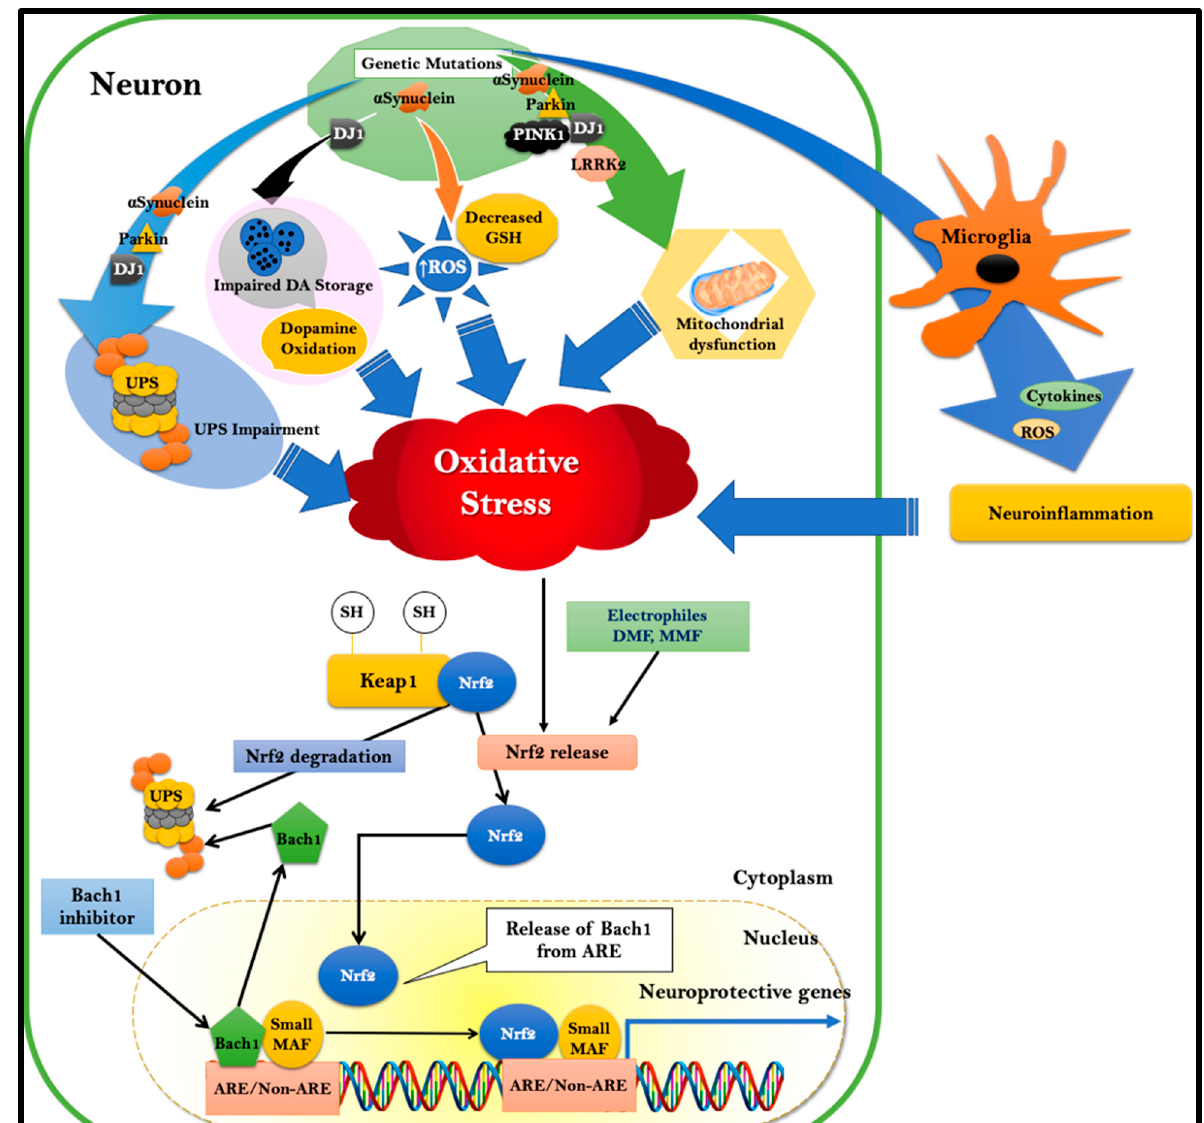
Figure 1. Cartoon showing the dysregulation of oxidative stress-mediated pathways in PD and the utility of the Nrf2/Bach1 signaling pathway as a therapeutic target. Mitochondrial dysfunction, proteasomal impairment, oxidative stress, and neuroinflammation are the key players underlying Parkinson’s pathophysiology. Both environmental factors and genetic mutations of DJ-1, Parkin, PINK1, α -synuclein, and LRRK2 increase oxidative stress, which results in neuronal cell death. Oxidative stress activates the Nrf2 pathway by covalently modifying the Keap1-Nrf2 interaction and releasing Nrf2 to translocate into the nucleus freely. Once in the nucleus, Nrf2 forms heterodimers with the small MAF protein, and this competitively displaces Bach1 from the ARE binding site. This results in the transcriptional activation of antioxidant, anti-inflammatory, and neuroprotective genes that work in unison against PD-associated neurodegenerative pathways. Electrophilic Nrf2 activators can also disrupt the Keap1-Nrf2 interaction and result in the activation